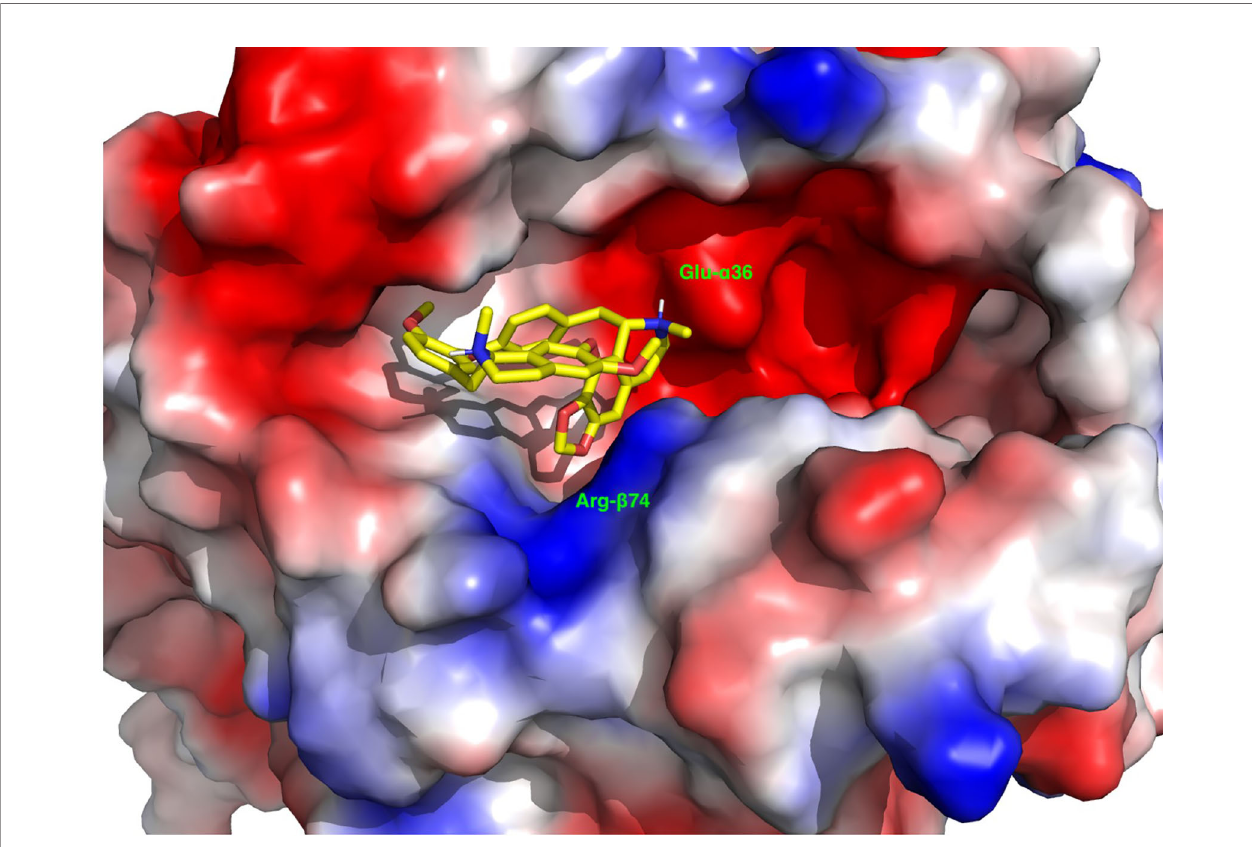
FIGURE 2 | A representative depiction of the binding of Cepharanthine to the binding pocket of the APS3v-associated HLA-DR3. The surface is colored by the electrostatic potential, where blue indicates a positive and red a negative electrostatic potential. Note the anchoring of the methylenedioxy group next to the Arg- b 74 (blue) and the positively charged methyl-piperidine group next to Glu- a